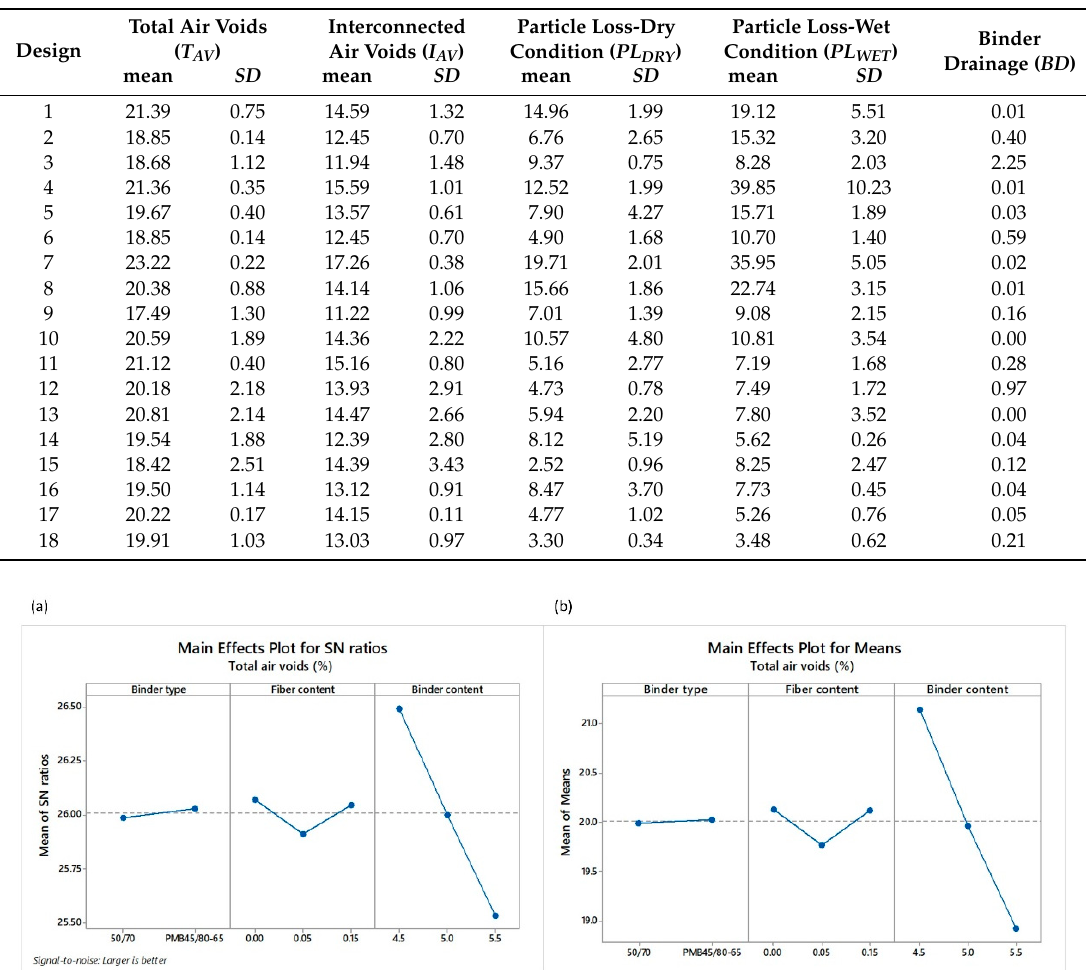
Table 6. L18 Taguchi orthogonal array response variables.